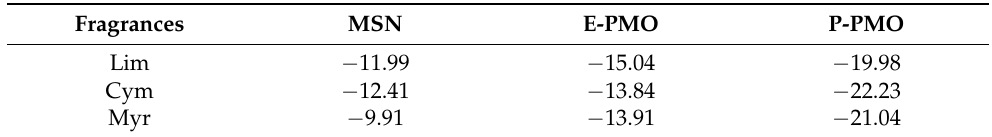
Table 3. Computed interaction energies of fragrance molecules with the bridging moieties in meso- porous silica and organosilica nanoparticles (kcal mol − 1